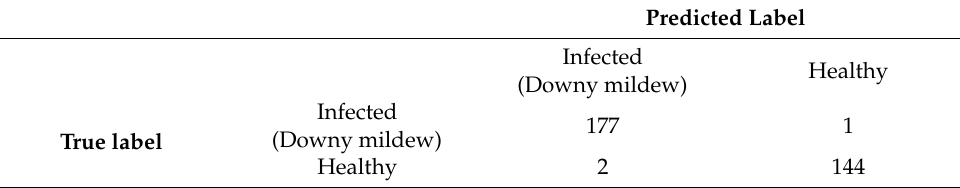
Table 2. Confusion matrix corresponding to the SVM method results on the test set. Only one patch corresponding to an infected leaf region was classified as healthy, while two patches corresponding to healthy leaves were classified as patches corresponding to infected regions. All other patches were correctly classified.